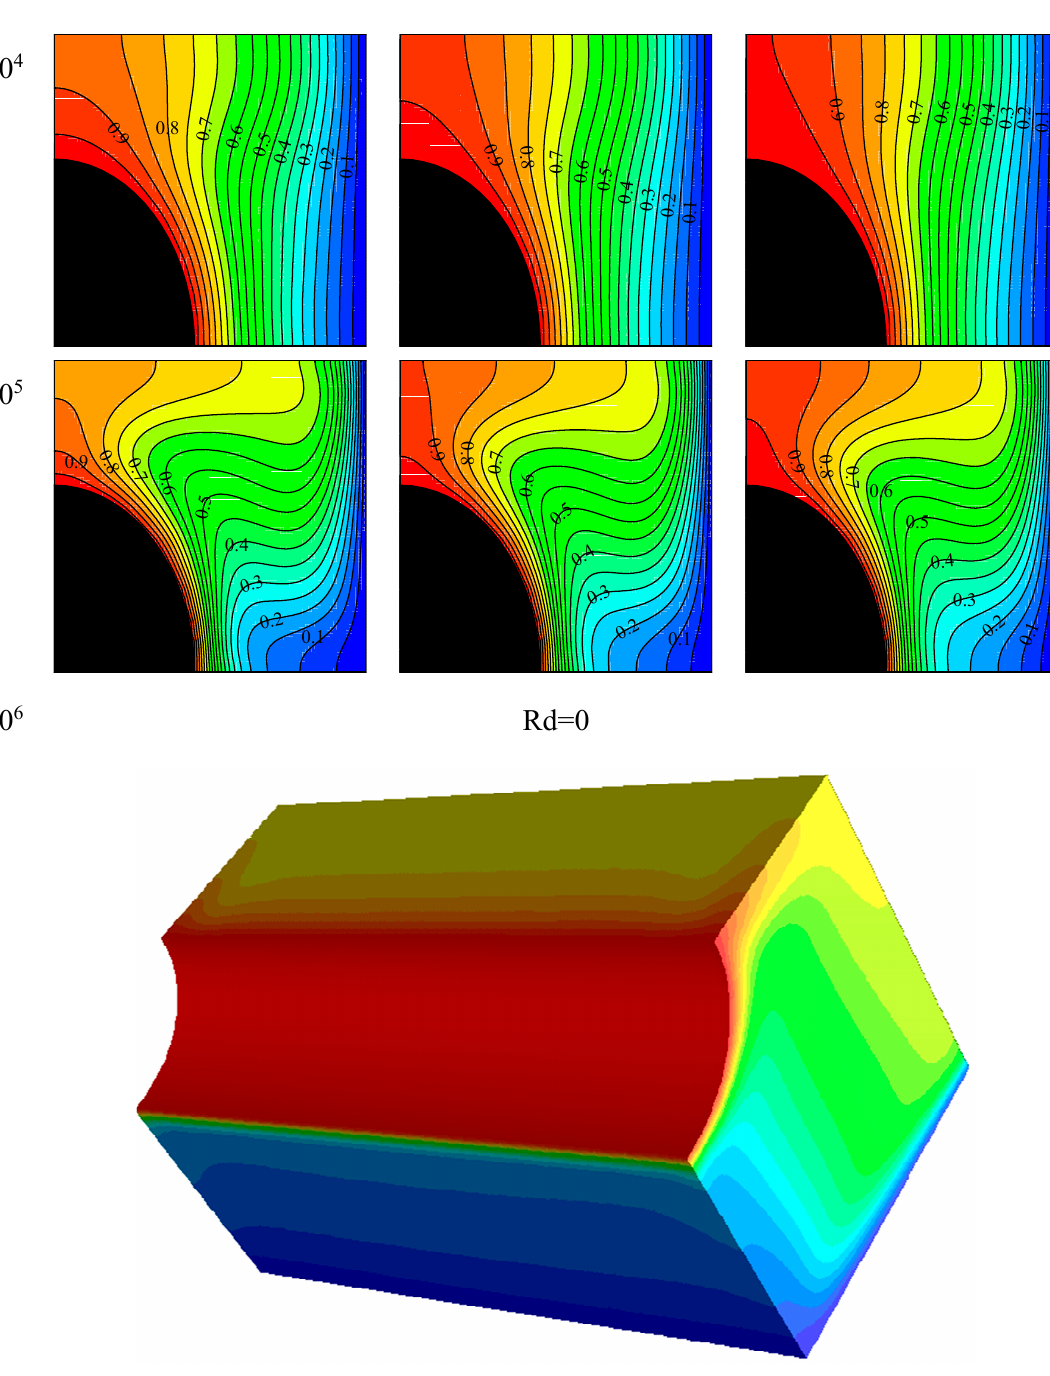
Figure 5. Isothermal line for 𝐻𝑎 = 20, 𝐴𝑅 = 0.45 − 0.6, 𝛾 = 45, 𝜔 = 0, 𝜑 = 0.03 , and different Rayleigh number and RAP values.